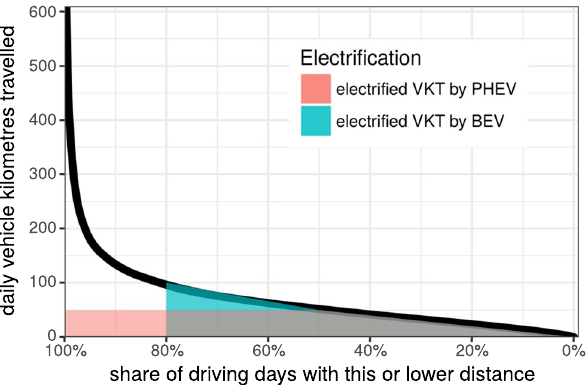
Figure 3. Overall distribution of daily VKT for a large daily driving data set. Also shown are the annual electrified VKT by BEV and PHEV with typical ranges as shaded areas under the